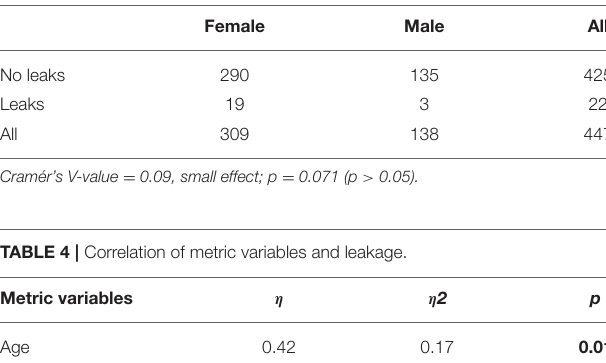
TABLE 5 | Descriptive data of age, fundus-wall thickness, and